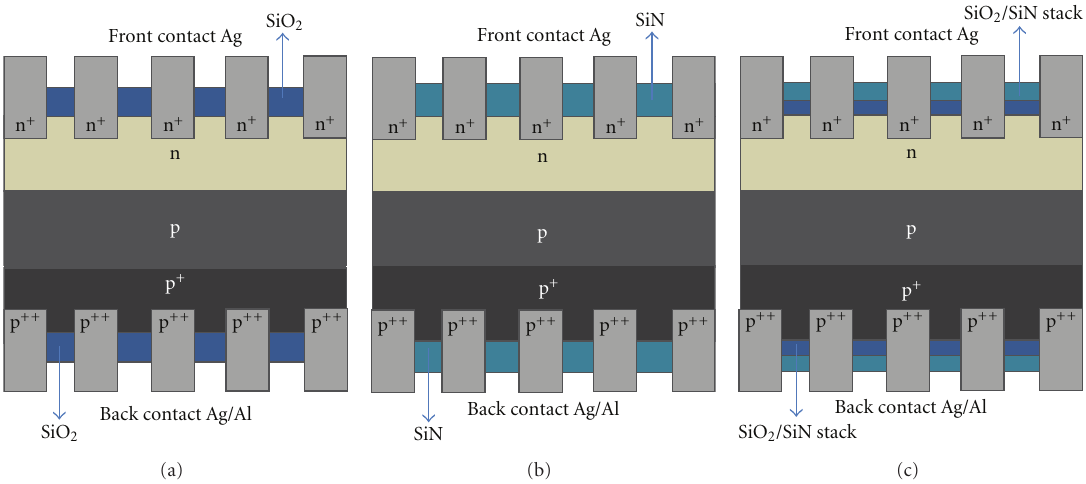
Figure 2: The n+pp+ structure of bifacial Si solar cells with di ff erent ARC on both sides, namely, (a) thermally grown SiO 2 or PECVD SiO 2 , (b) PECVD SiN and (c) SiO 2 /SiN stack.